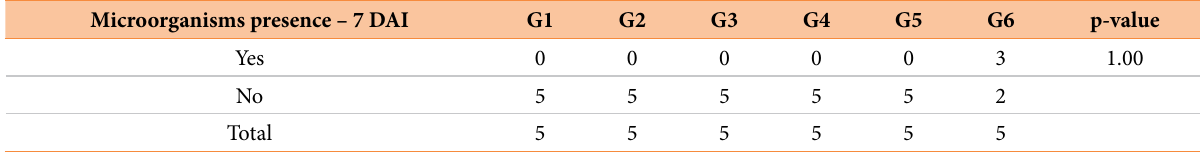
Table 5 - Microscopic detection of microorganisms in partial thickness burn wounds experimentally induced in Wistar rats treated with calcium and/or sodium alginate hydrogel-based dressings*.